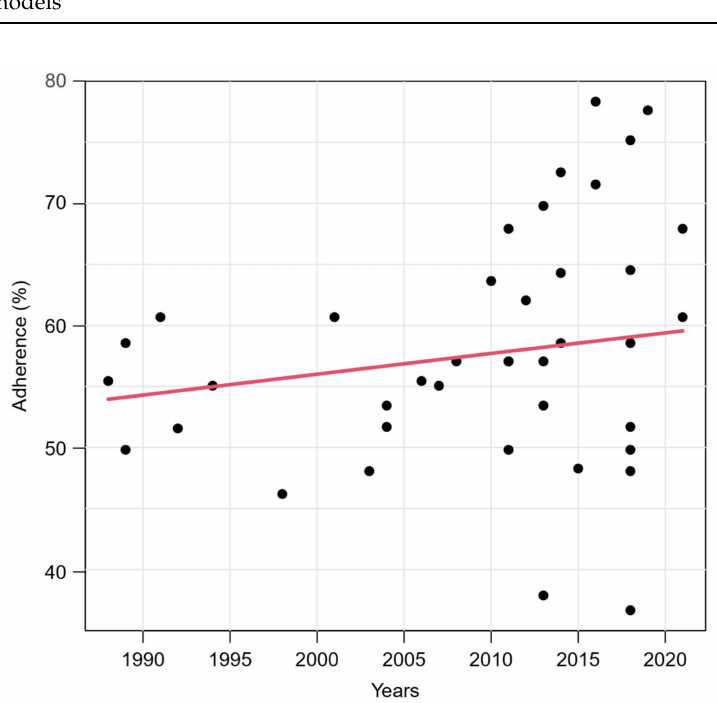
Figure 3. Relationship between TRIPOD adherence and publication year of studies. Red line represents predicted mean curve from a beta regression model based on 40 studies (two studies were excluded, see